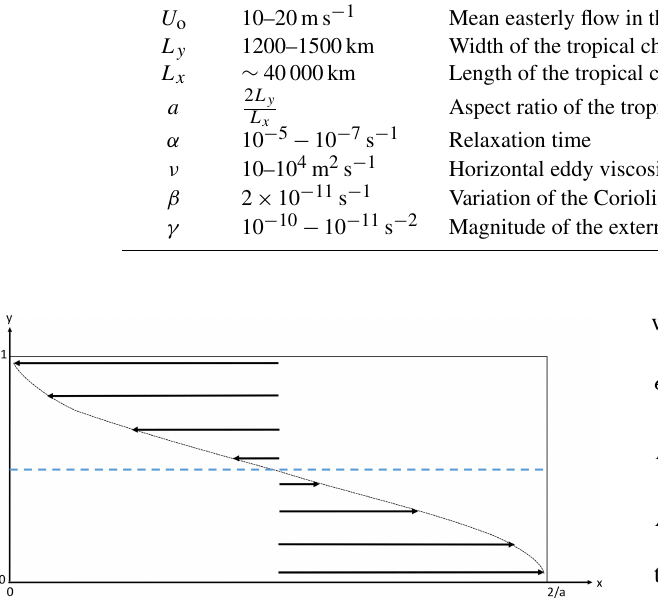
Figure 1. Illustration of the zonal wind that is derived from the steady-state flow ψ S in the ITCZ model (Eq. 1) with the external forcing given by Eq. (3). The dotted curve represents the horizontal profile of the mean flow, while the black arrows represent the direc- tion of the mean flow for the tropical channel domain (cid:127) a . The blue dashed line denotes the location of the